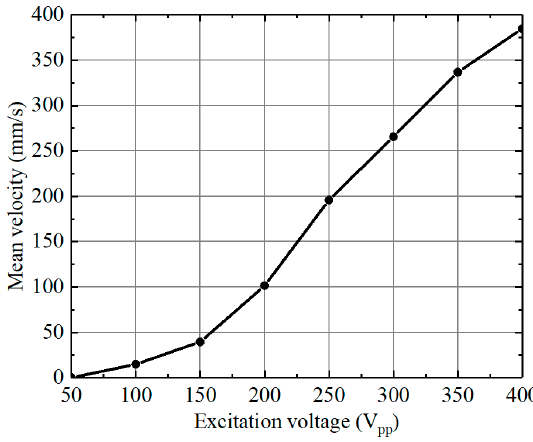
Figure 11. Measured motion characteristic of the framed piezoelectric actuator prototype.